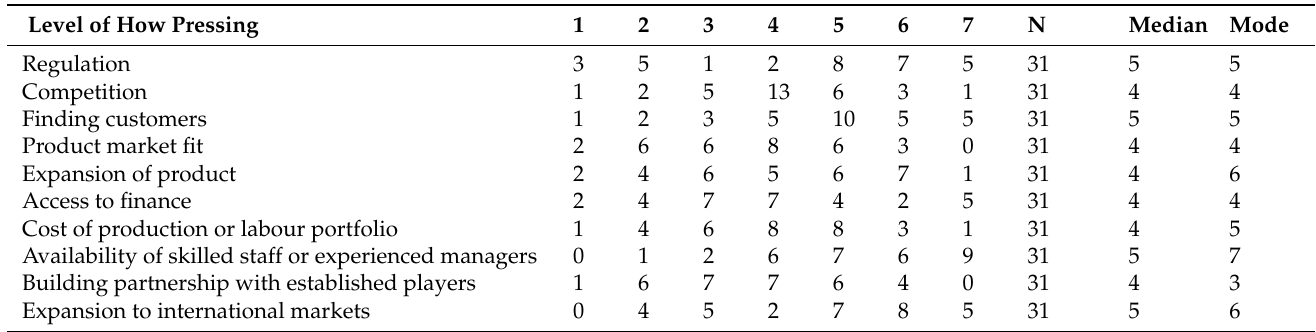
Table 1. Responses to the question of how pressing specific problems are; 1 = not pressing, 7 = extremely pressing.